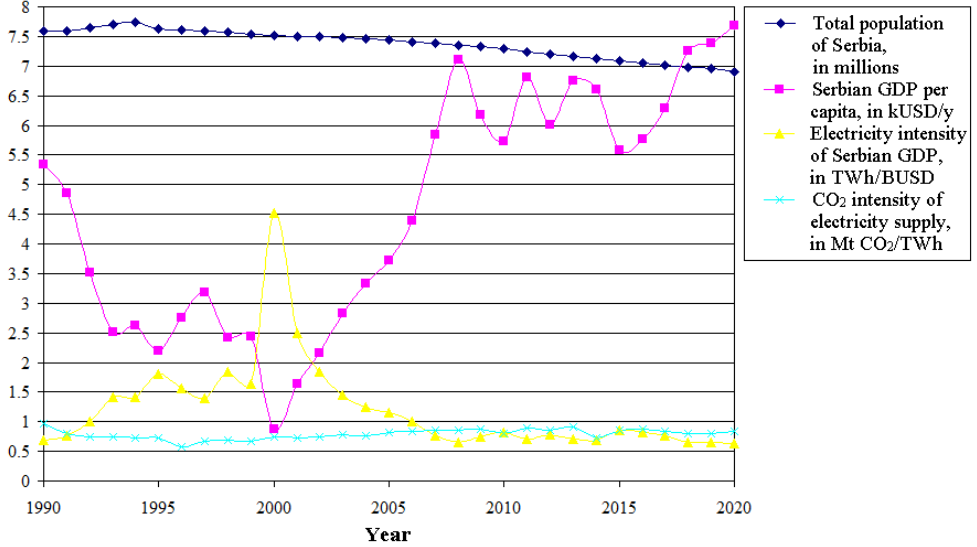
Figure 3. Changes in the Kaya identity factors.